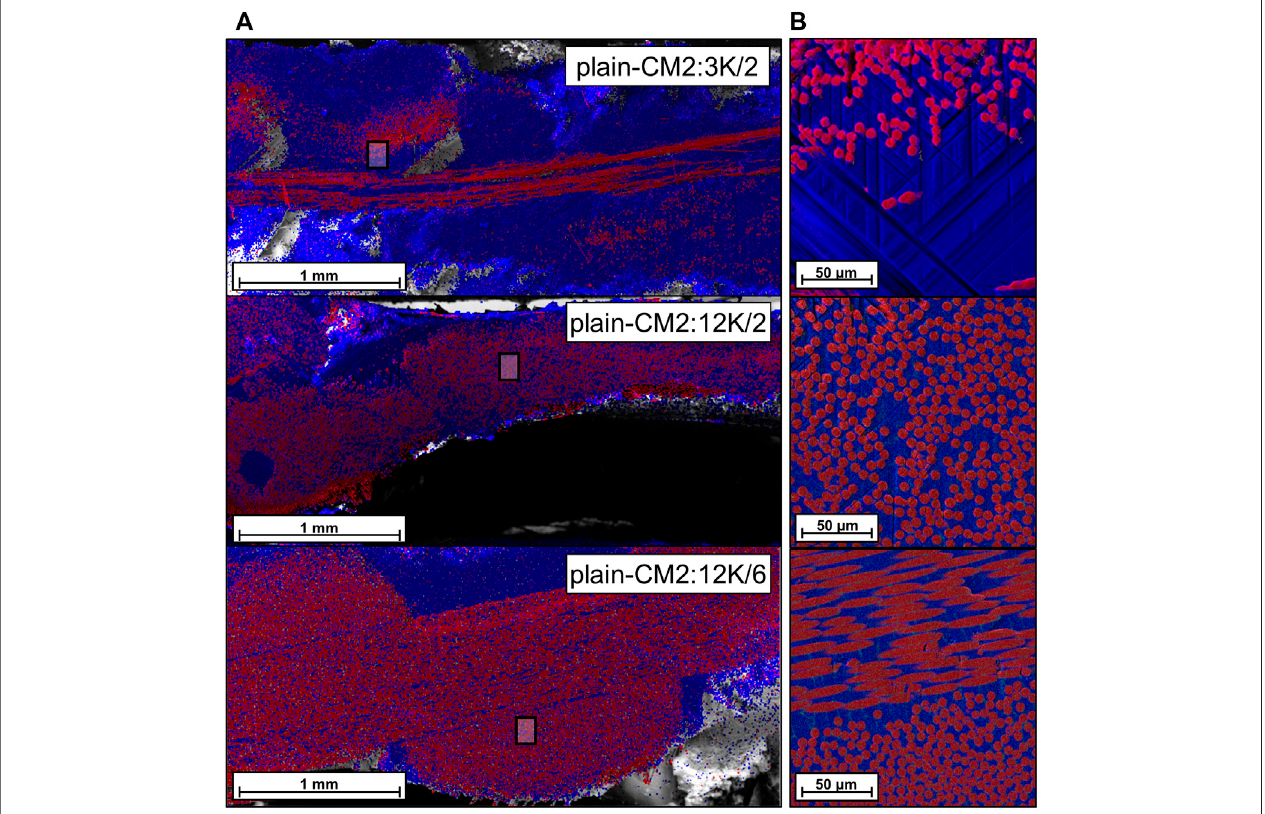
FIGURE 2 | Comparing the packing density of plain weave fabrics at different tow sizes and yarn inputs. Cryo-BIB-SEM analyses with EDX (red = C, blue = O) of cross-sections from plain-CM2 fabricsafter operation in BES. Round dots arecarbon fi laments oriented roughly perpendicular to thecross-section. Figuretitles contain tow size [K]/yarn input [yarns/cm]. (A) Overview images, scale bars are 1 mm; (B) Zoom-in on areas marked in (A) , scale bars are 50 µm. Increasing tow size and yarn inputs decrease fabric porosity.